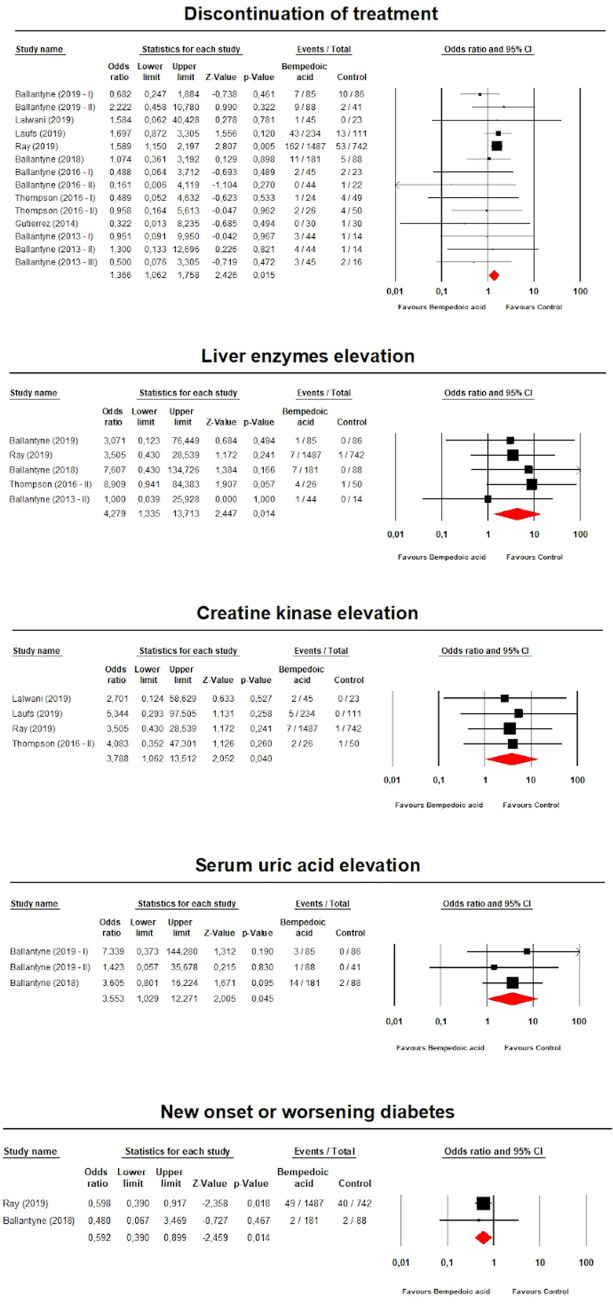
Forest plot comparing the risk of adverse events statistically associated with bempedoic acid treatment.